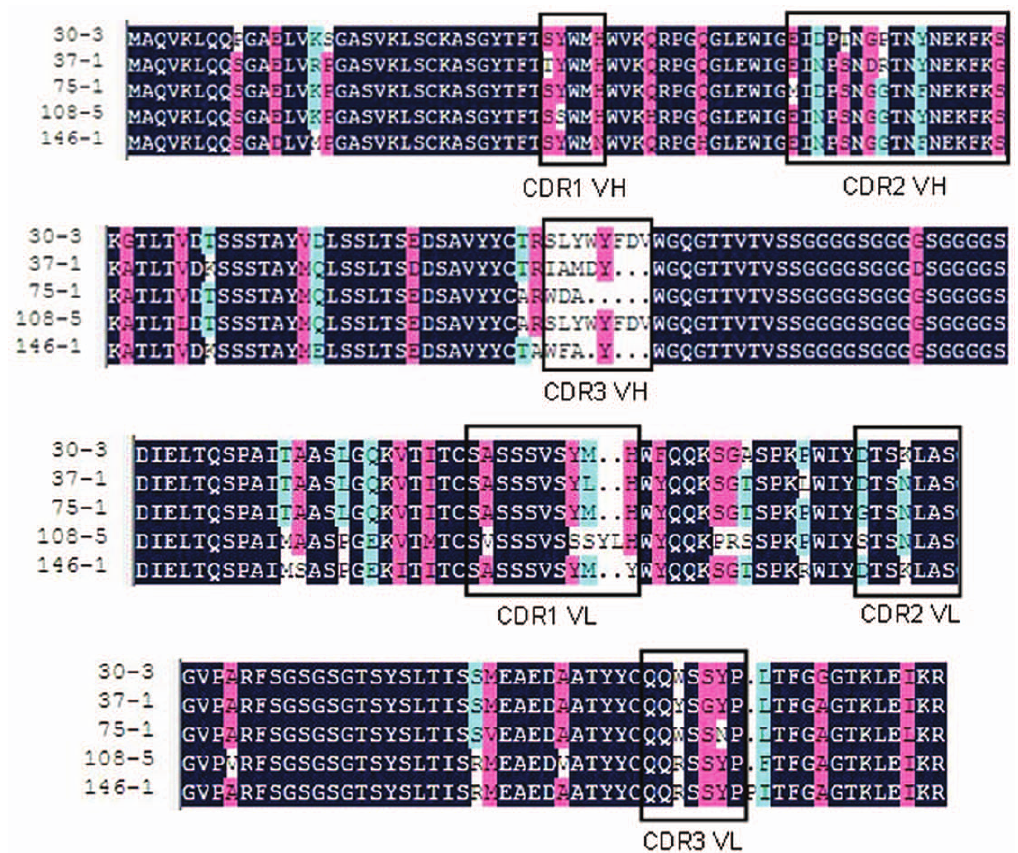
Figure 7. Deduced amino acid sequences of the five different scFvs from the competitive ELISA. The deleted residues are represented by a dash (-). FRs and CDRs were determined according to Kabat database.